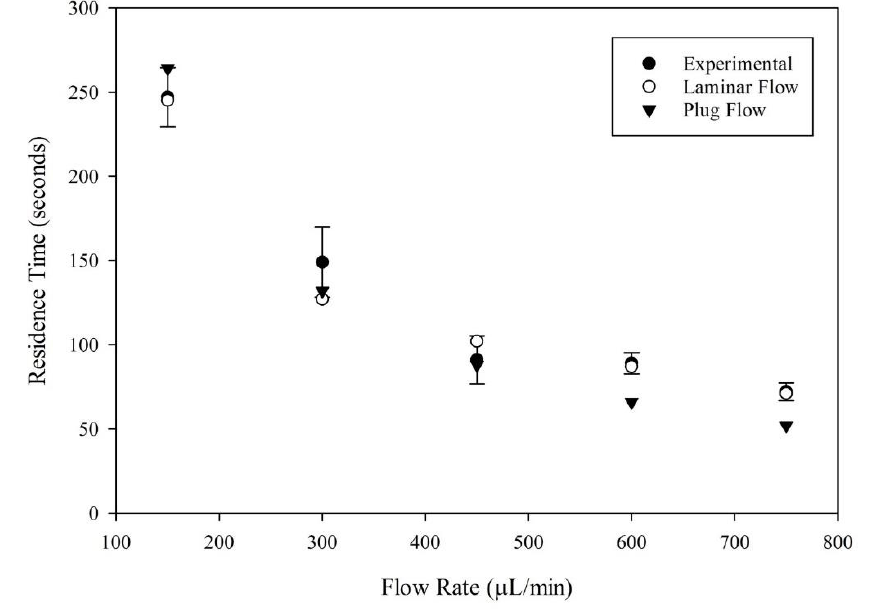
Figure 4. Theoretical residence time comparison.